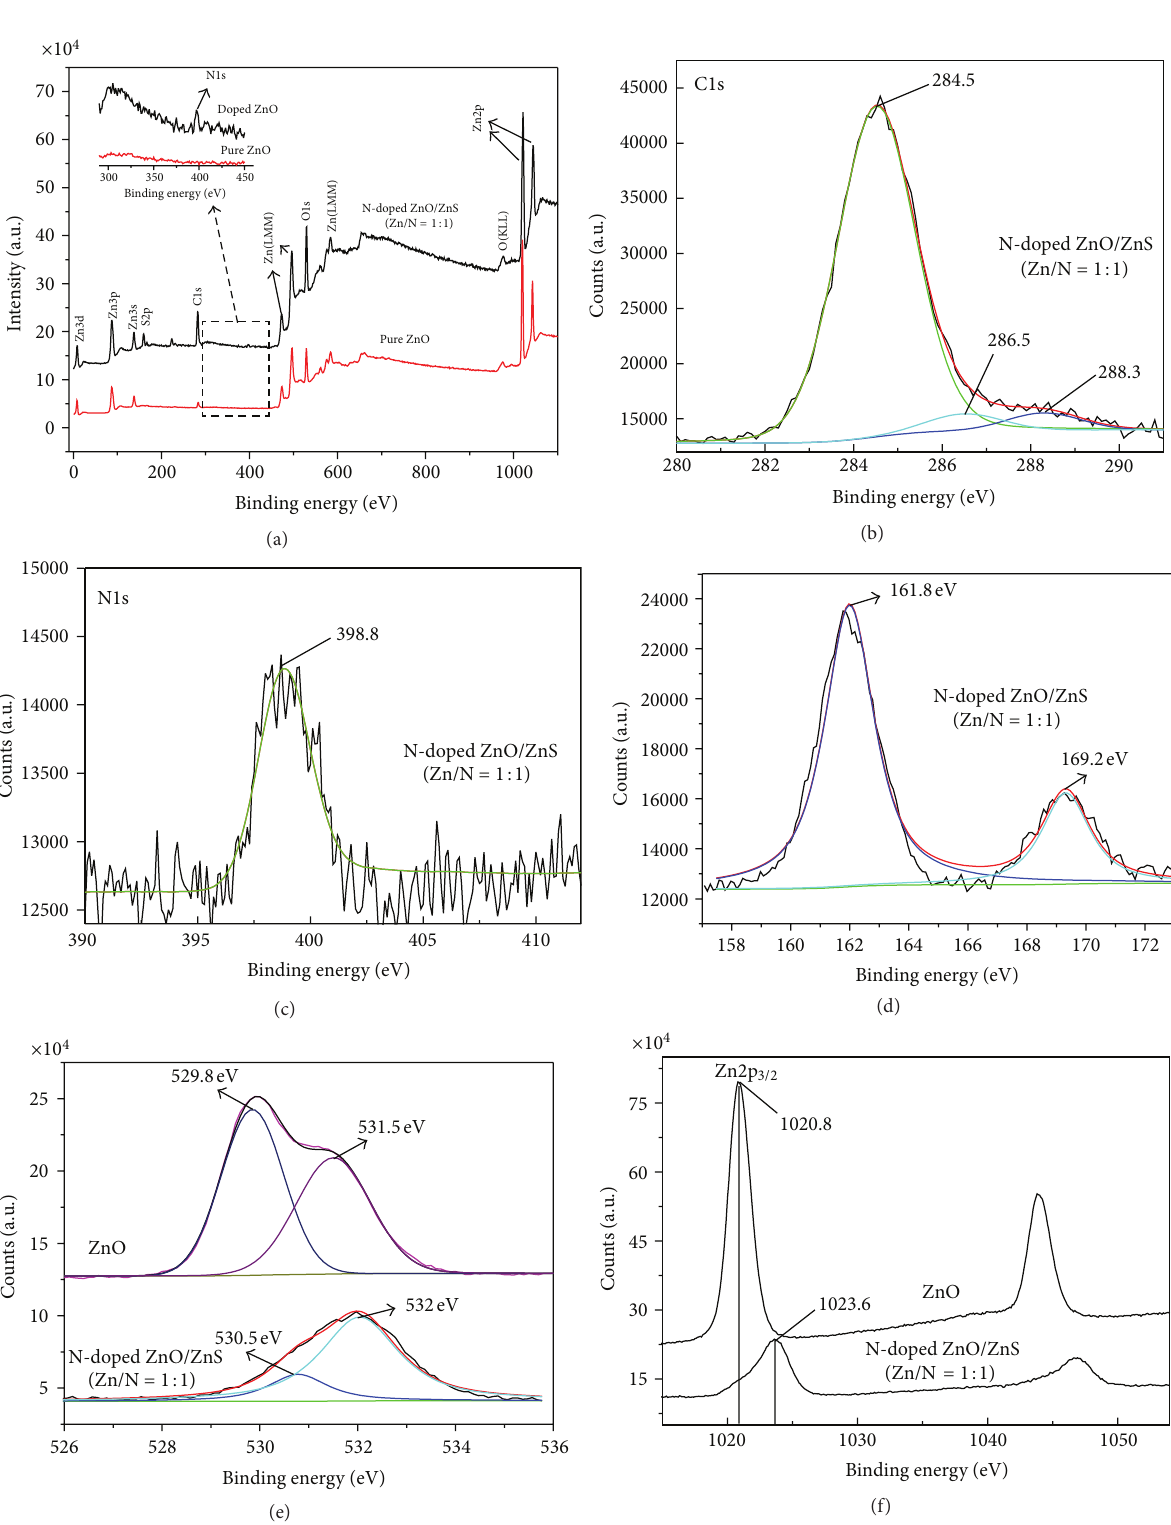
) u . . ( a s n t u o C